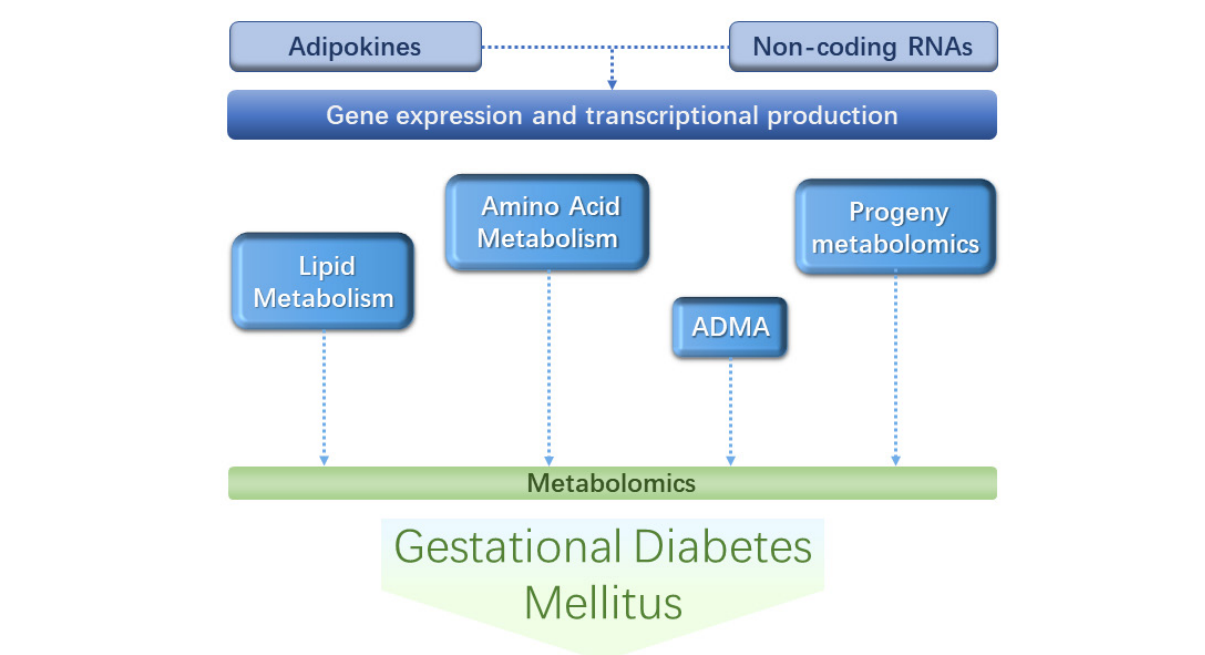
Figure 2. Conceptual diagram of associations among maternal GDM and offspring health outcomes throughout gestation to adulthood. The co-regulation of adipokines, lncRNA, and microRNA affect the metabolic changes and induce the occurrence of diseases and produce possible adverse consequences for